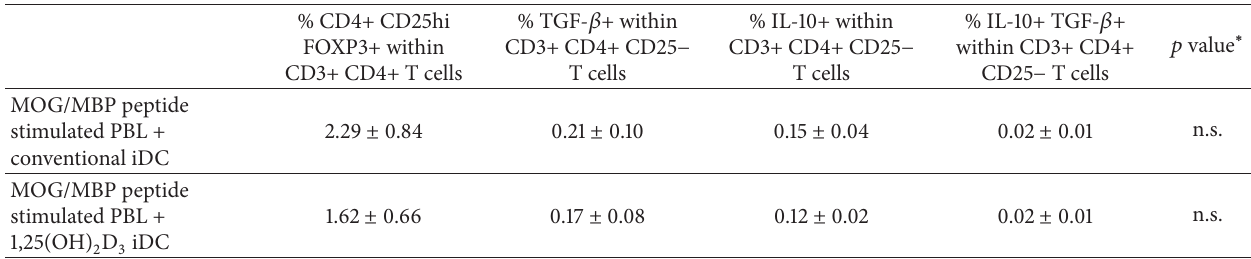
Table 4: Flow cytometric analysis of CD4+ CD25hi FOXP3+ Treg and immunosuppressive cytokine-expressing Treg in cultures of PBL stimulated with MOG- and MBP-derived peptides in the presence or absence of conventional and 1,25(OH) 2 D 3 -treated DC.